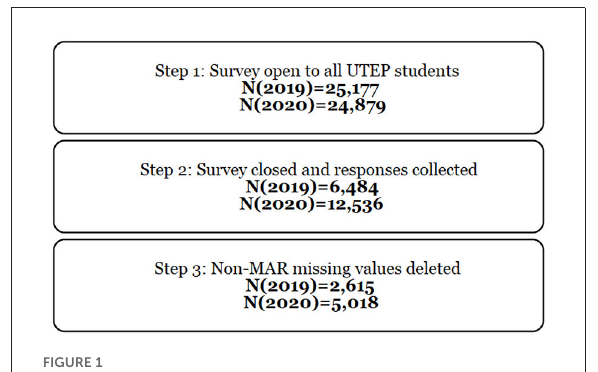
FIGURE1 Consort diagram of 2019 and 2020 data